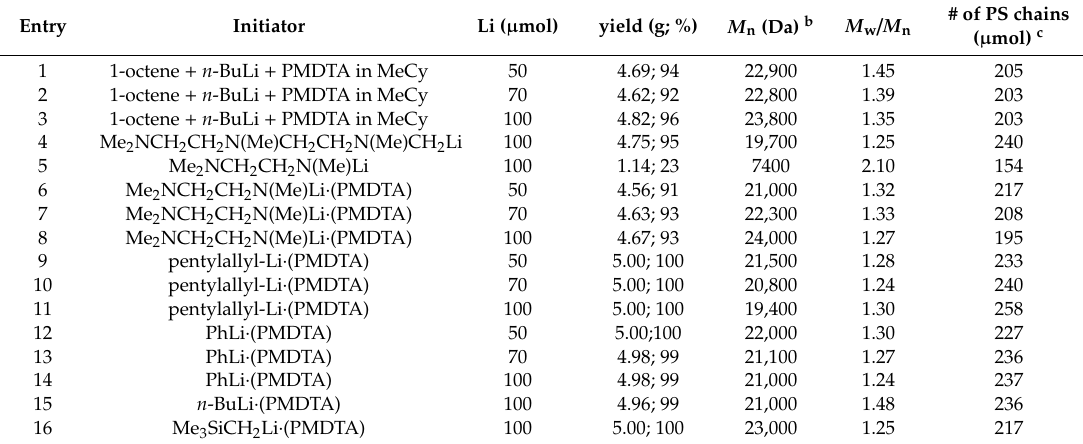
Table 2. Results of anionic styrene polymerization in the presence of (1-hexyl) 2 Zn (100 µmol) a .